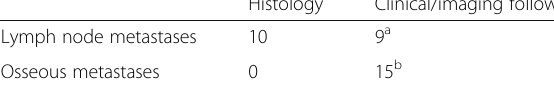
Table 2 Reference standard of lesions